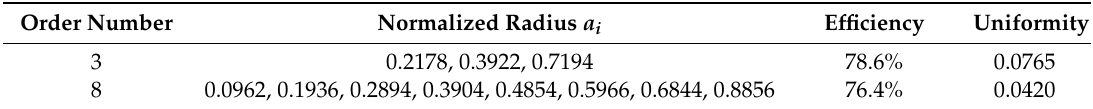
Table 1. Parameters and optical performances of the binary-phase LC